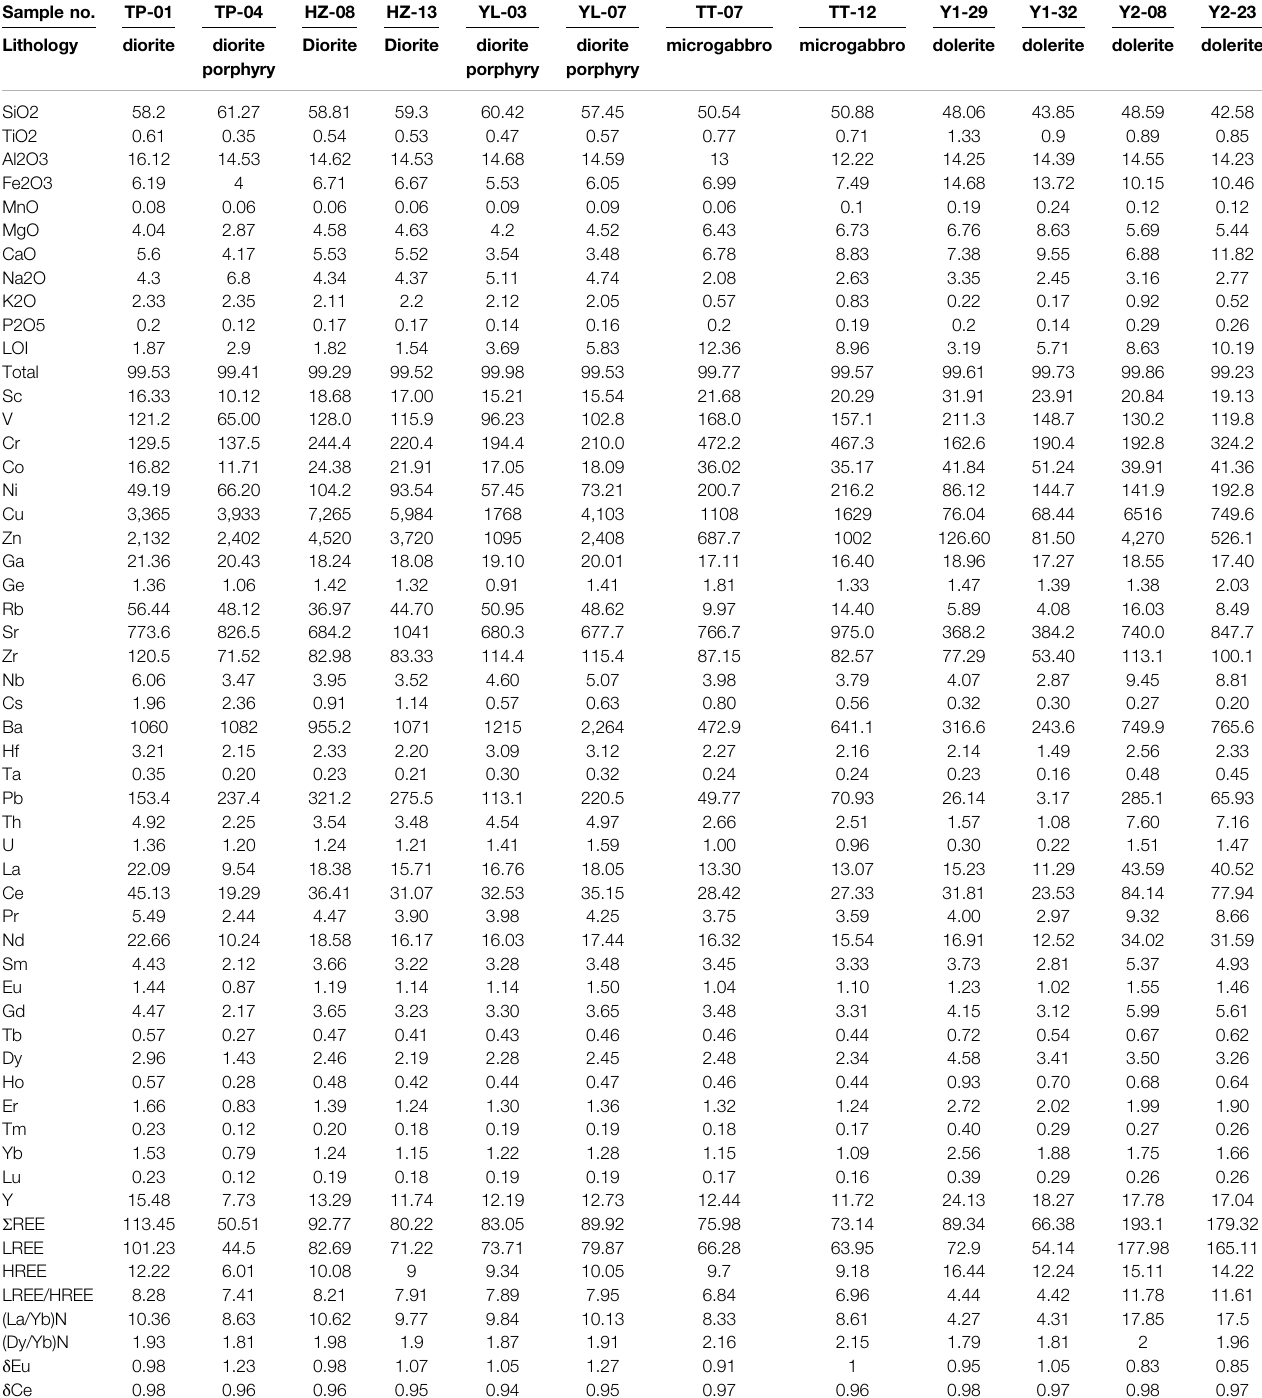
TABLE 4 | | Major and trace element compositions of plutonic rock samples from the Huaibei-Linhuan coal fi eld. Sample